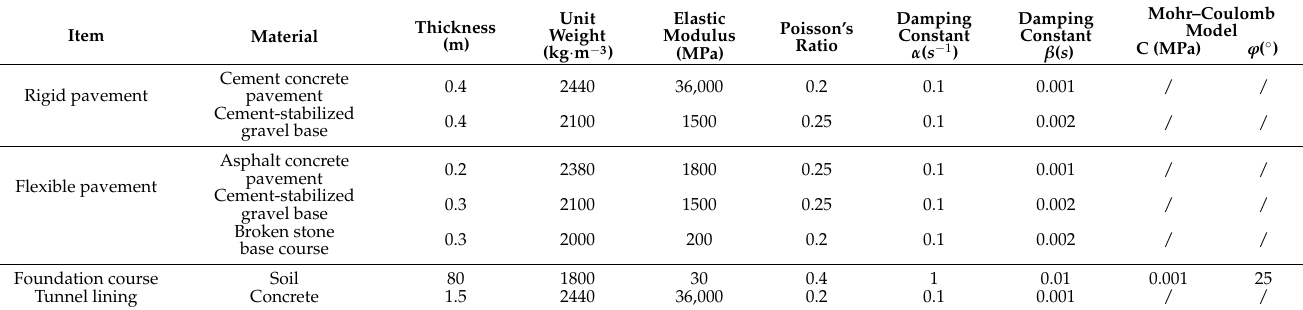
Table 1. The main material